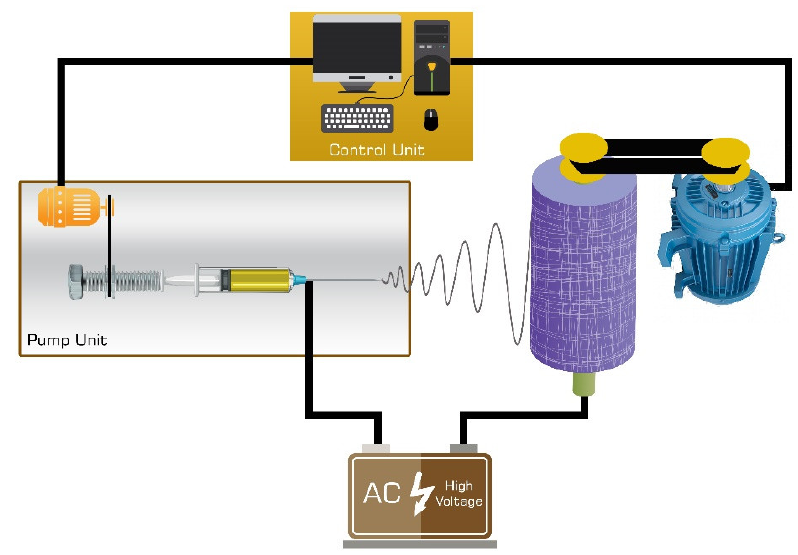
Figure 1. Schematic diagram of electrospinning of PAN/MWCNT/MOF nanofiber.